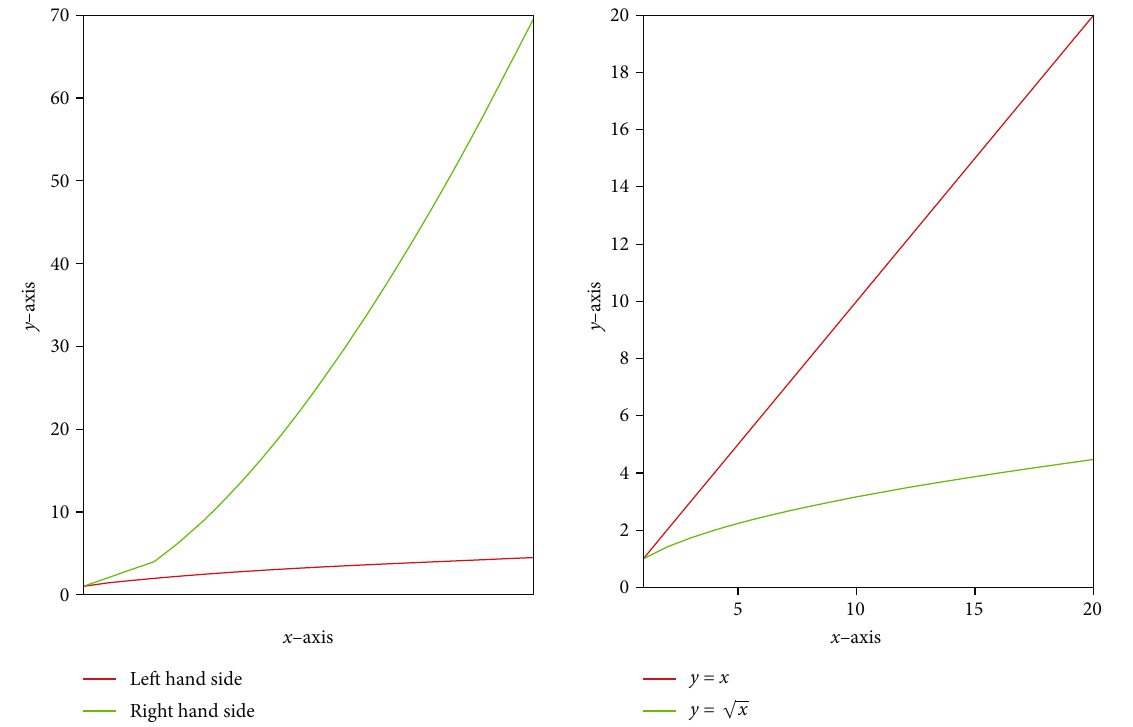
ffiffiffi p and y = x with fi xed x